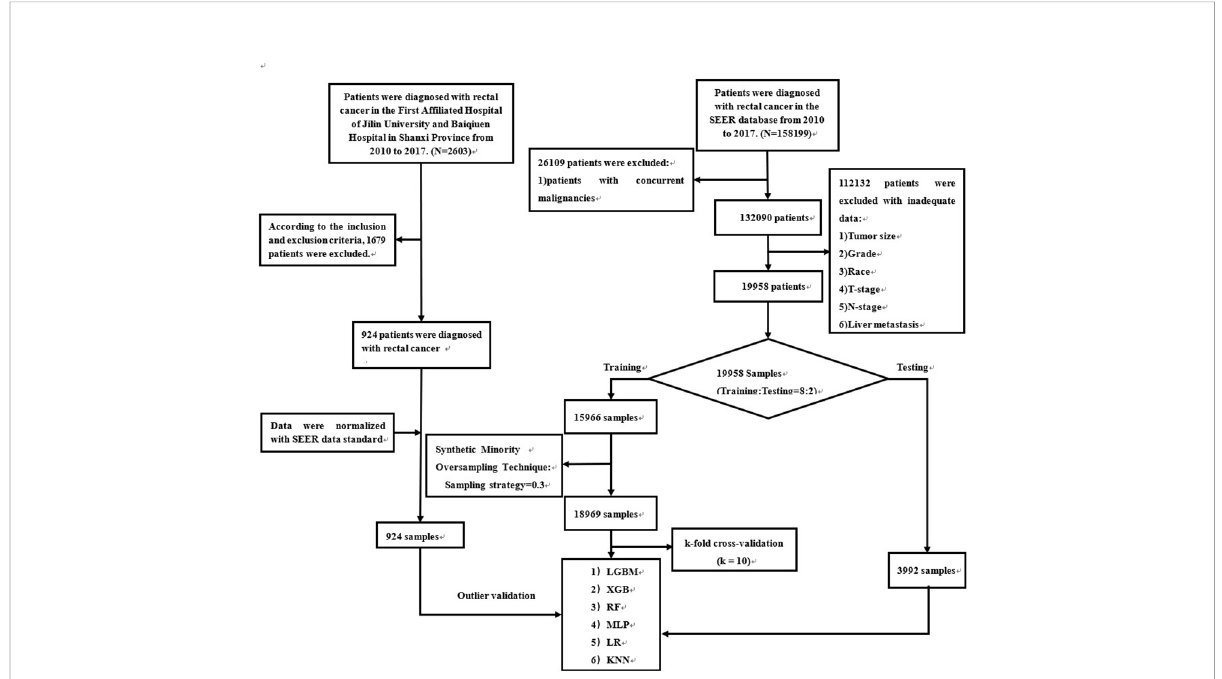
FIGURE 1 The work fl ow of the selection procedure for rectal cancer patients. Abbreviations: LGBM, light gradient boosting; XGB, extreme gradient boosting; RF, random forest; LR, logistic regression; KNN, K-nearest neighbor; MLP, multilayer